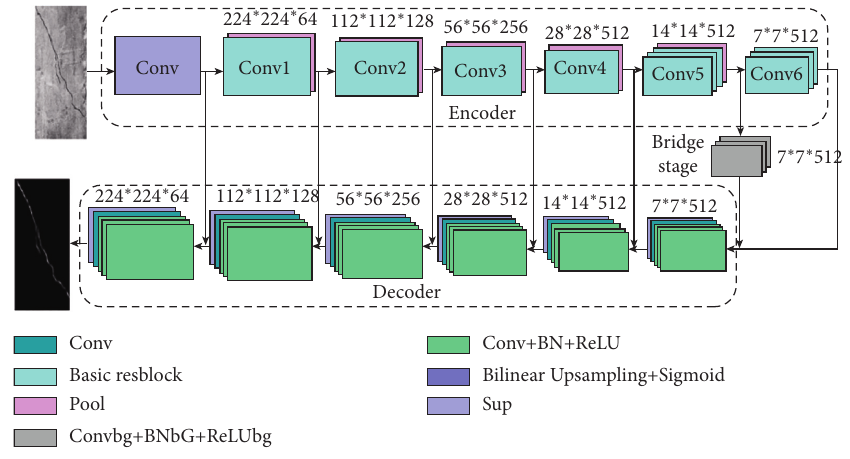
Figure 6: CEDNet.